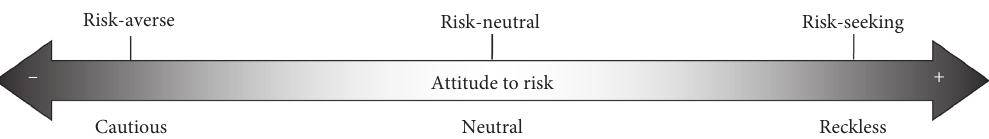
Figure 2: Bipolar continuum of attitudes to risk.